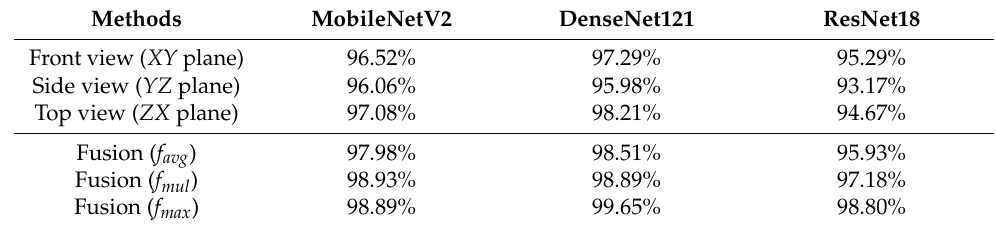
Table 2. Human activity recognition with different modality and models using UTD-MHAD